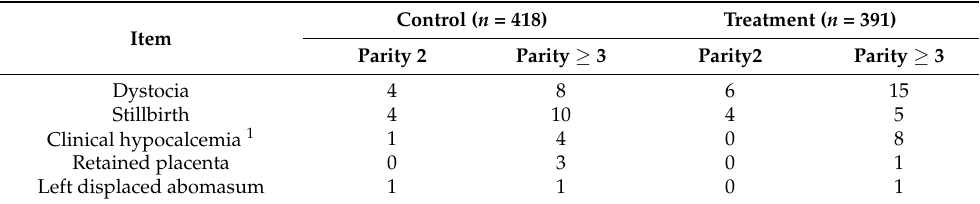
Table 1. Early lactation disorders in a randomized clinical trial evaluating the effects of an oral postpar- tum calcium supplementation strategy in multiparous Jersey cows ( n = 809) in a dairy in west TX.